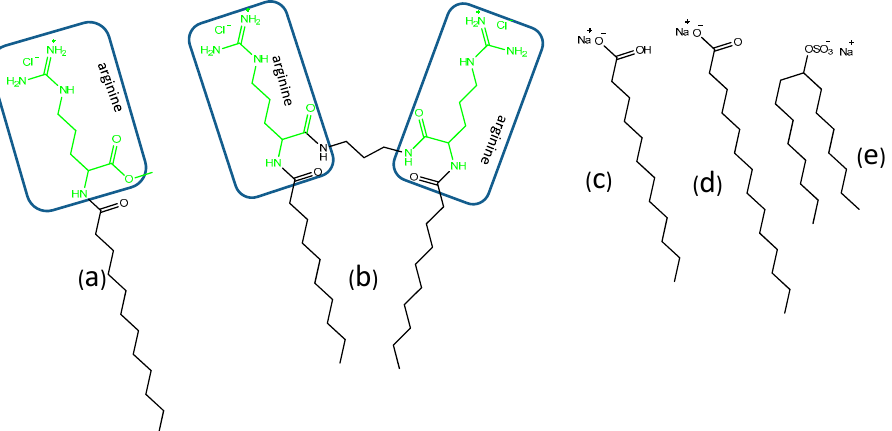
Figure 1. Chemical structure of the cationic and anionic surfactants used in this work: ( a ) LAM ( b ) C 3 (CA) 2 , ( c ) Sodium laurate, ( d ) Sodium myristate, and ( e ) 8-SH.